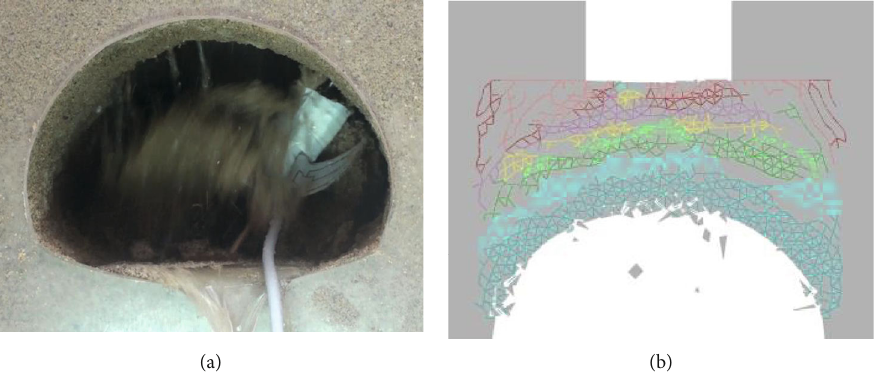
Figure 16: Contrast of destruction between (a) physical experiment and (b) UDEC simulation ( N = 8